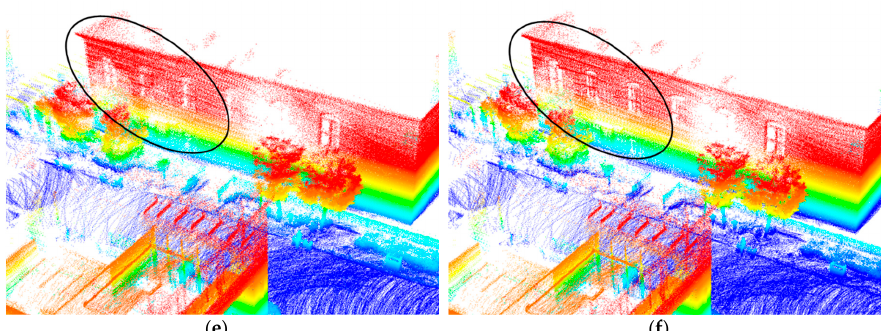
Figure 12. Snapshots of the point cloud produced by Cartographer before (left) and after optimization (right). ( a , b ) A scene in dataset 1; ( c , d ) a scene in dataset 2; ( e , f ) a scene in dataset 3.